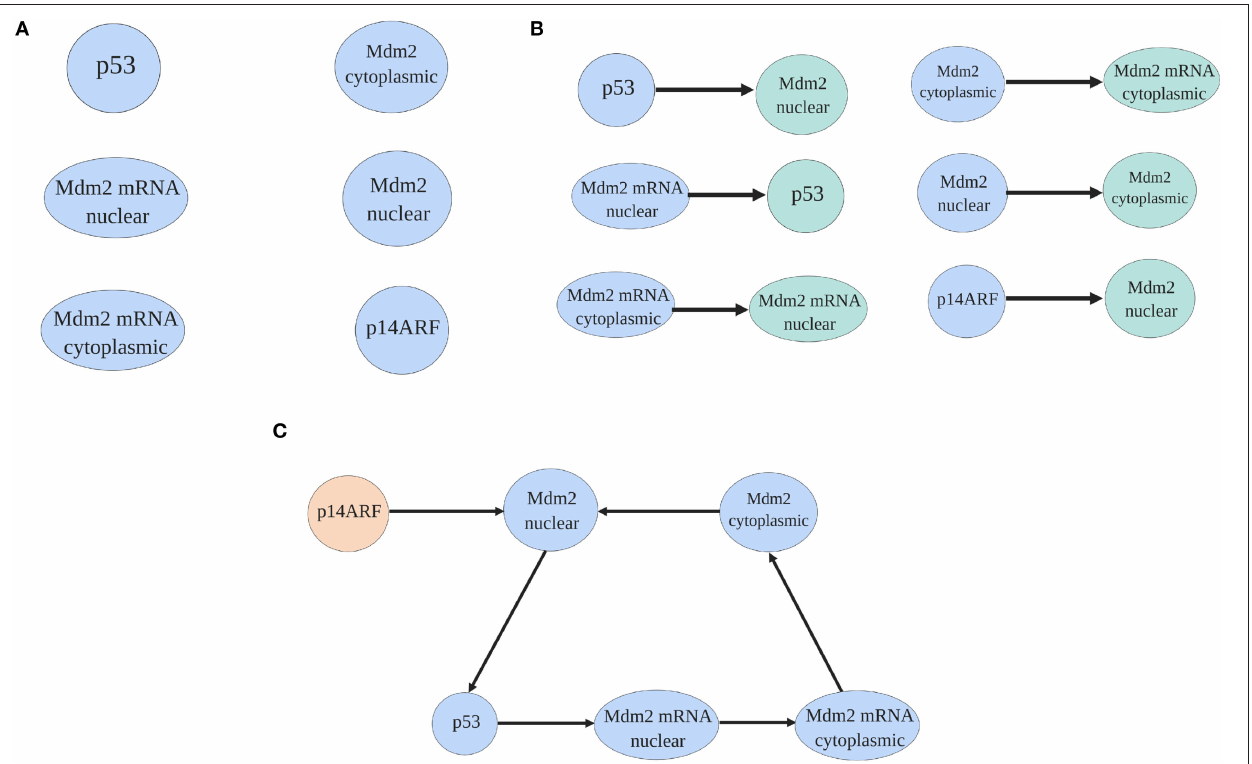
FIGURE 2 | Spanning tree process of the p53-Mdm2 network regulated by p14ARF. In (A) proteins and mRNA of the network are presented. In (B) based on the mathematical model (1–6) and doing a biological analysis, proteins, and mRNA are illustrated with their dependent molecule. Finally, in (C) the spanning tree where p14ARF do not have direct dependence (virtual leader) from other protein/mRNA is